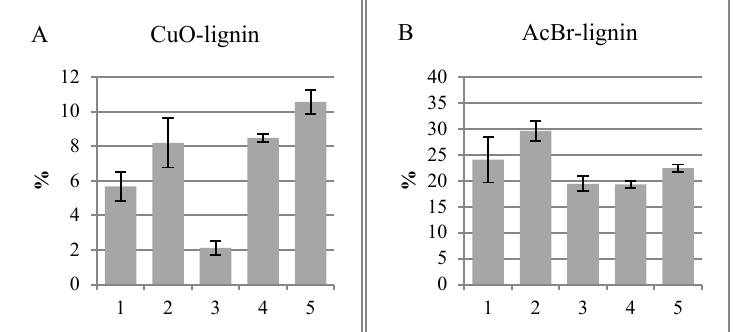
Figure 6. The same silver birch tissues analyzed by CuO and AcBr methods. ( A ) The sum of the monomers released by the CuO method; ( B ) the total lignin amount estimated by the AcBr method. 1, Cork cambium; 2, non-conductive phloem; 3, combined conductive phloem, cambium and differentiating xylem; 4, lignified xylem; 5, previous year’s